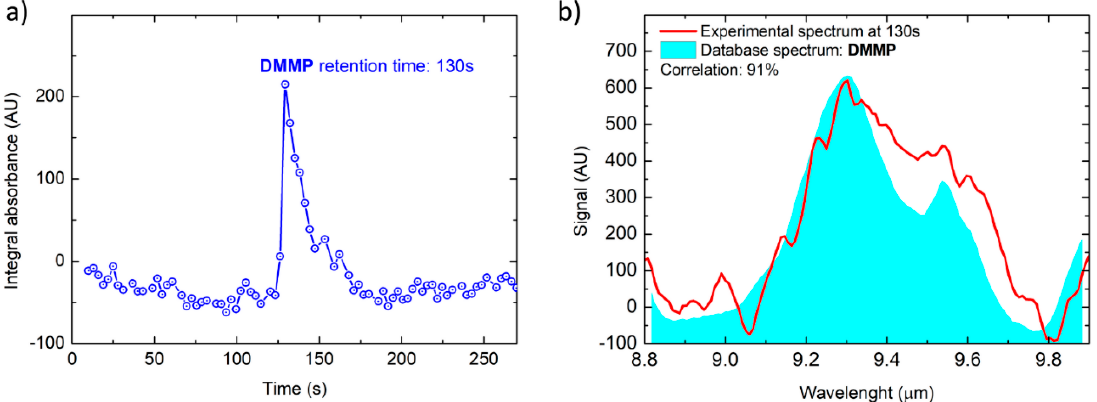
Figure 13. DMMP with strong gasoline background: total absorption chromatogram ( a ) and DMMP spectrum acquired at T = 130 s ( b ).